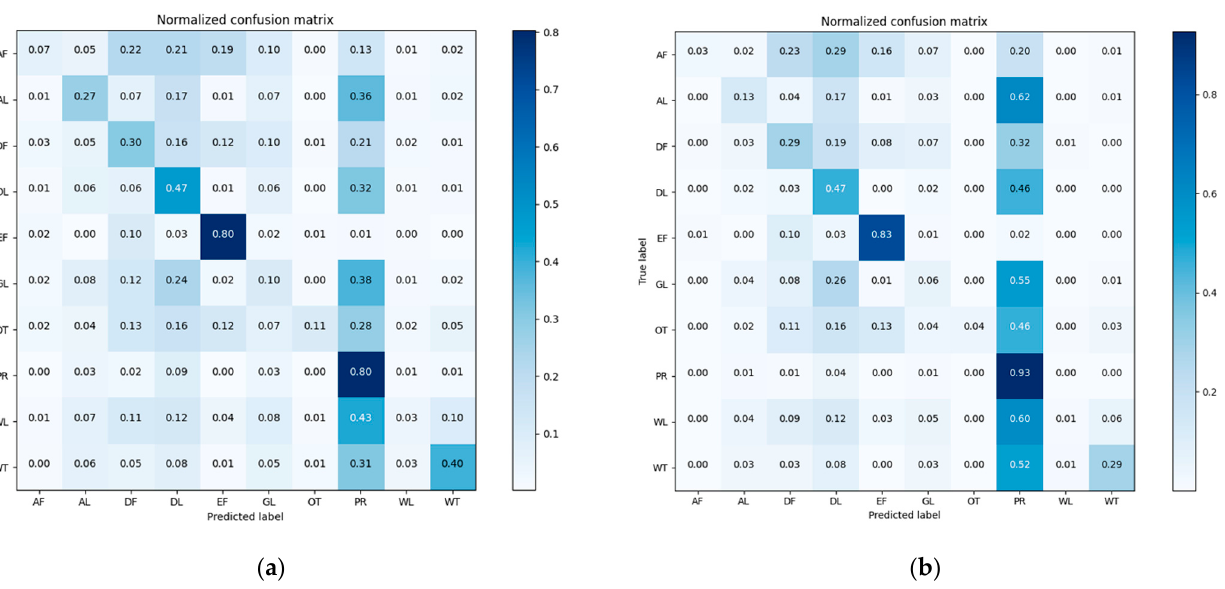
Figure 8. Confusion matrixes of the Mun River Basin for ( a ) pre-classification results and ( b ) neighborhood spatial rela- tionship and fuzzy classification fusion results.